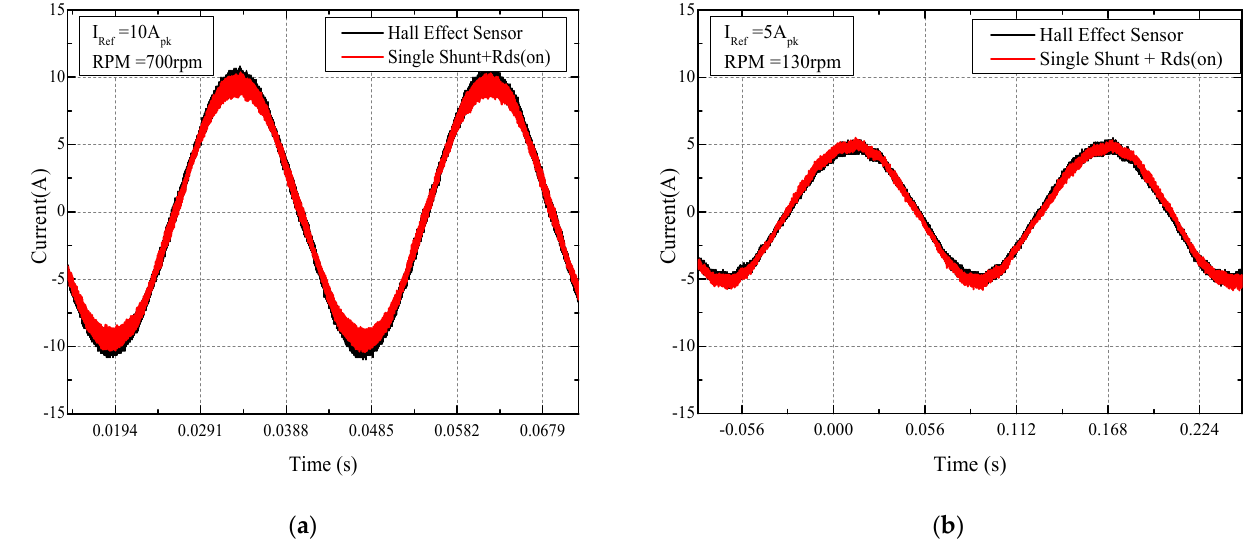
Figure 12. ( a ) 700 rpm@10 A pk Rds(on), temperature, current (rms) waveform; ( b ) 130 rpm@5 A pk Rds(on), temperature, current (rms).